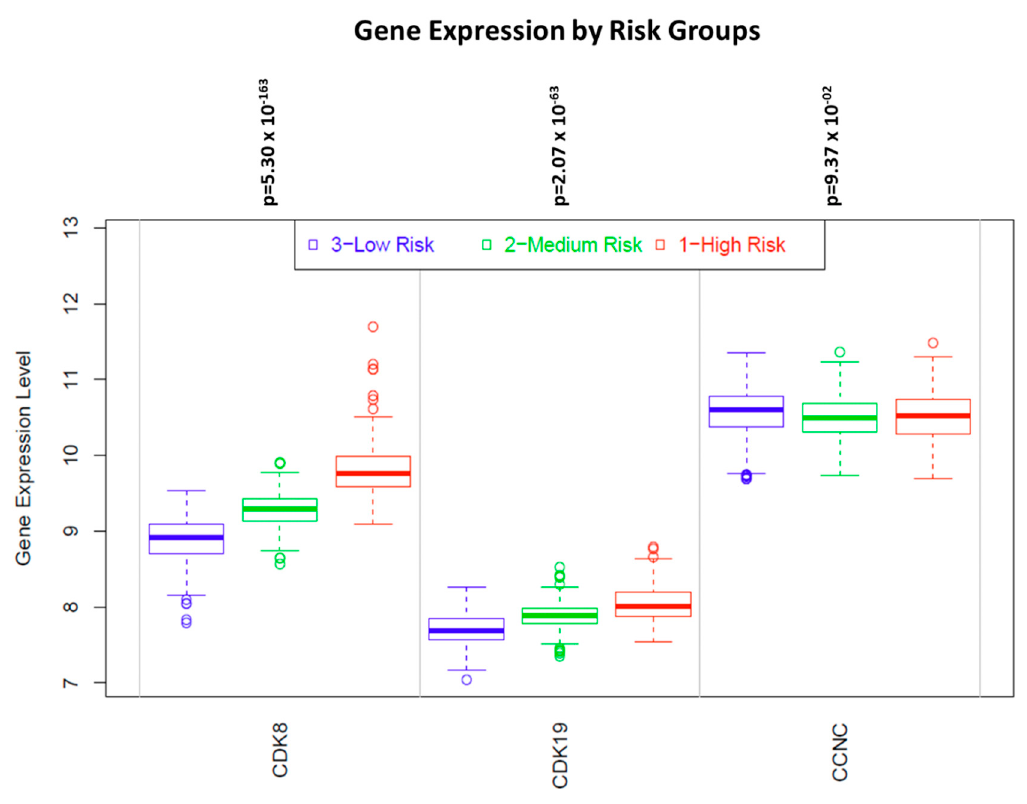
Figure 7. Levels of CDK8 / CDK19 / CCNC expression in three equal-size groups of colon cancers patients stratified by increasing risk, in the curated SurvExpress dataset (http://bioinformatica.mty.itesm.mx:8080/Biomatec/SurvivaX.jsp) of 808 colon cancers.